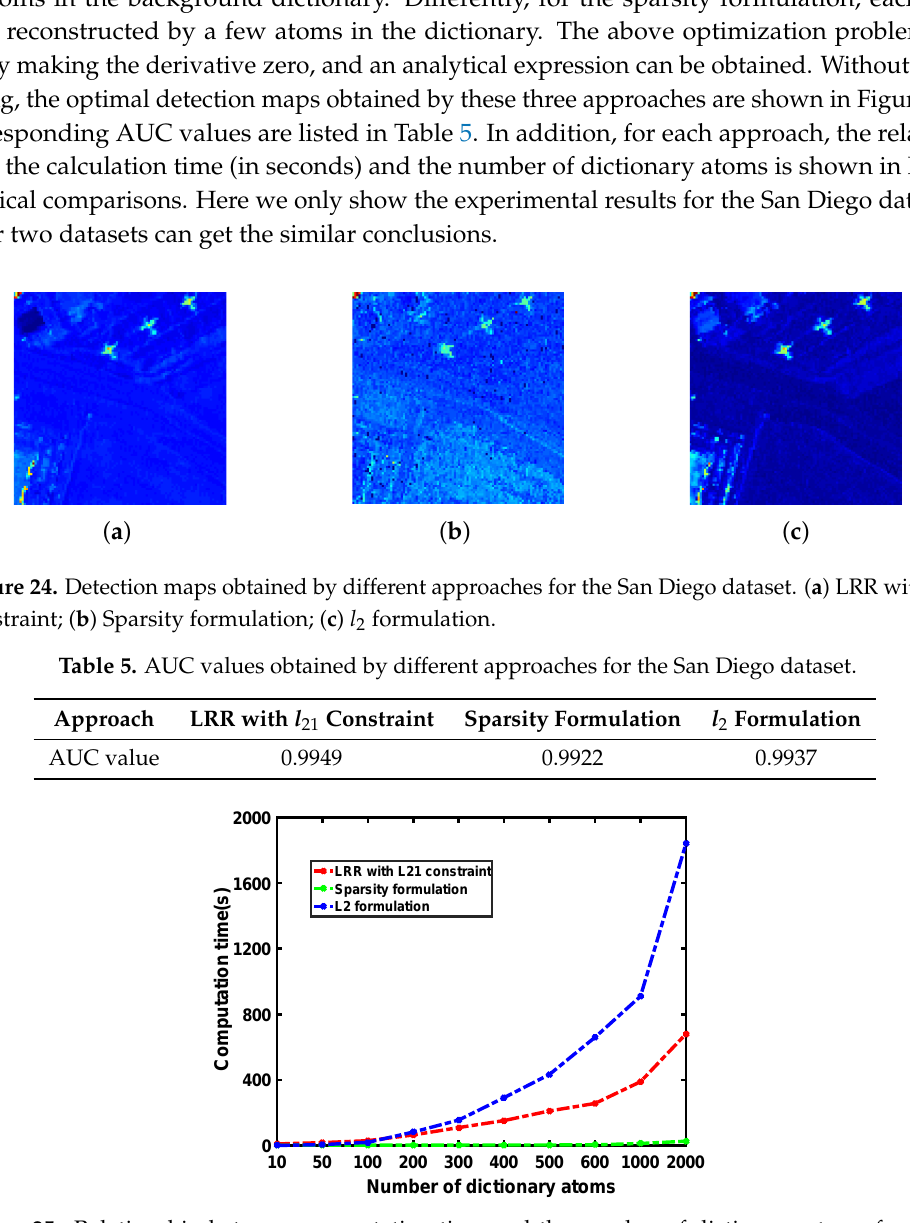
Figure 25. Relationship between computation time and the number of dictionary atoms for each approach for the San Diego